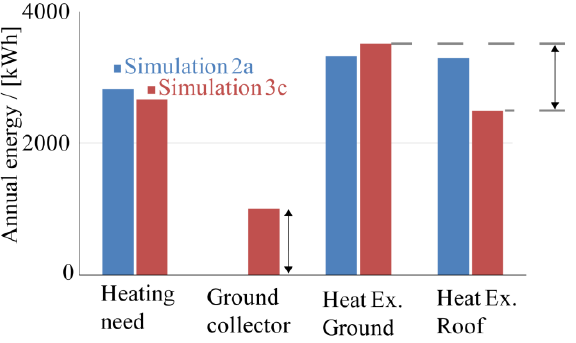
Figure 4. The annual energy flows for a low energy building for two simulation cases, Case 2a in blue and Case 3c in red.